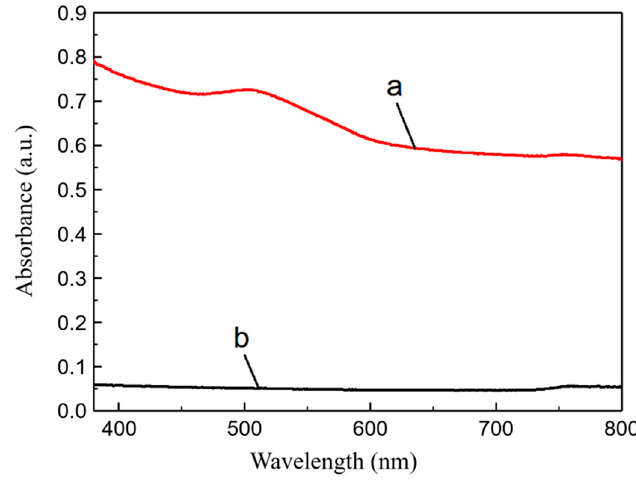
Figure 10. UV-vis pattern of water (a) and Cu 2 O nanochains-water nanofluids (b).